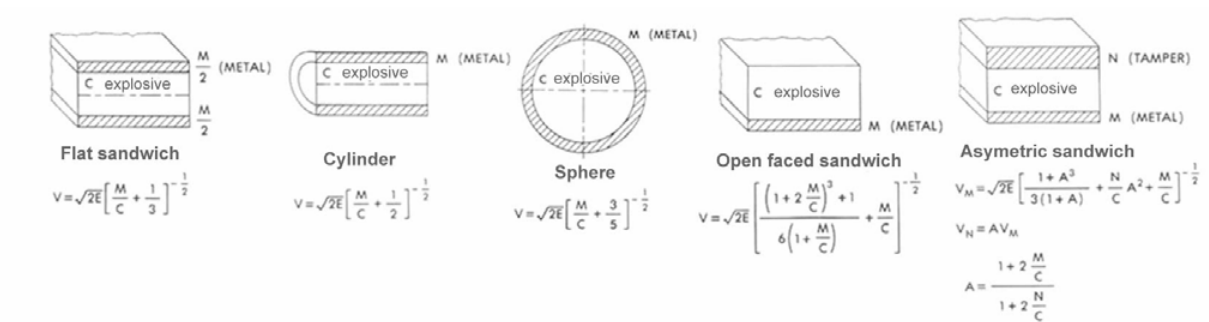
Fig. 2 Expressions for initial velocities of fragments in different geometric configurations [adopted from